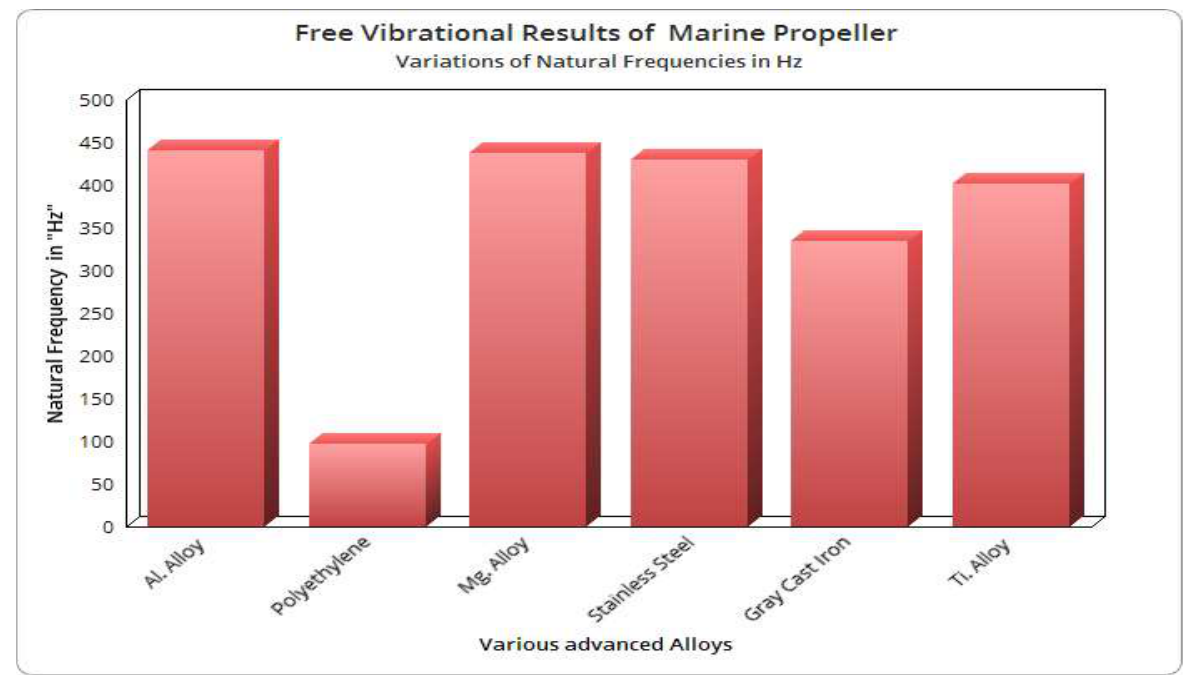
Figure 49. Free vibrational results of various alloys based marine propeller.